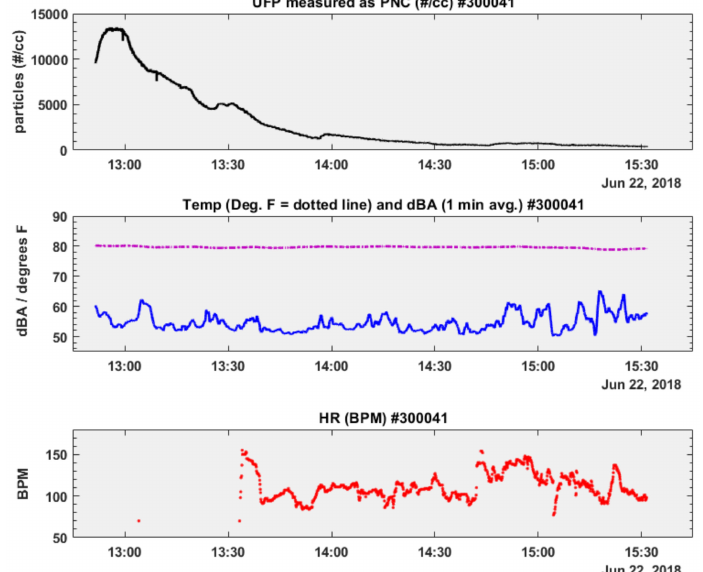
Figure 8. Time-series subplots of PNC, Temp., dBA, Heart Rate: participant # 300041 (22 June